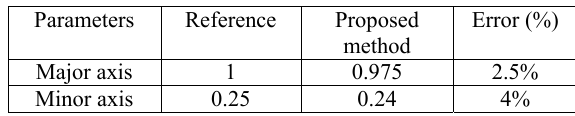
Table 2: Validations of cylinder shape